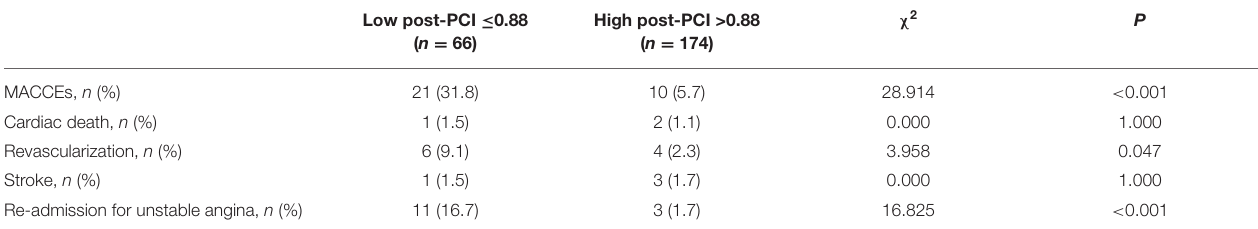
TABLE 4 | Incidence of adverse outcomes according to post-PCI QFR of the target vessel.